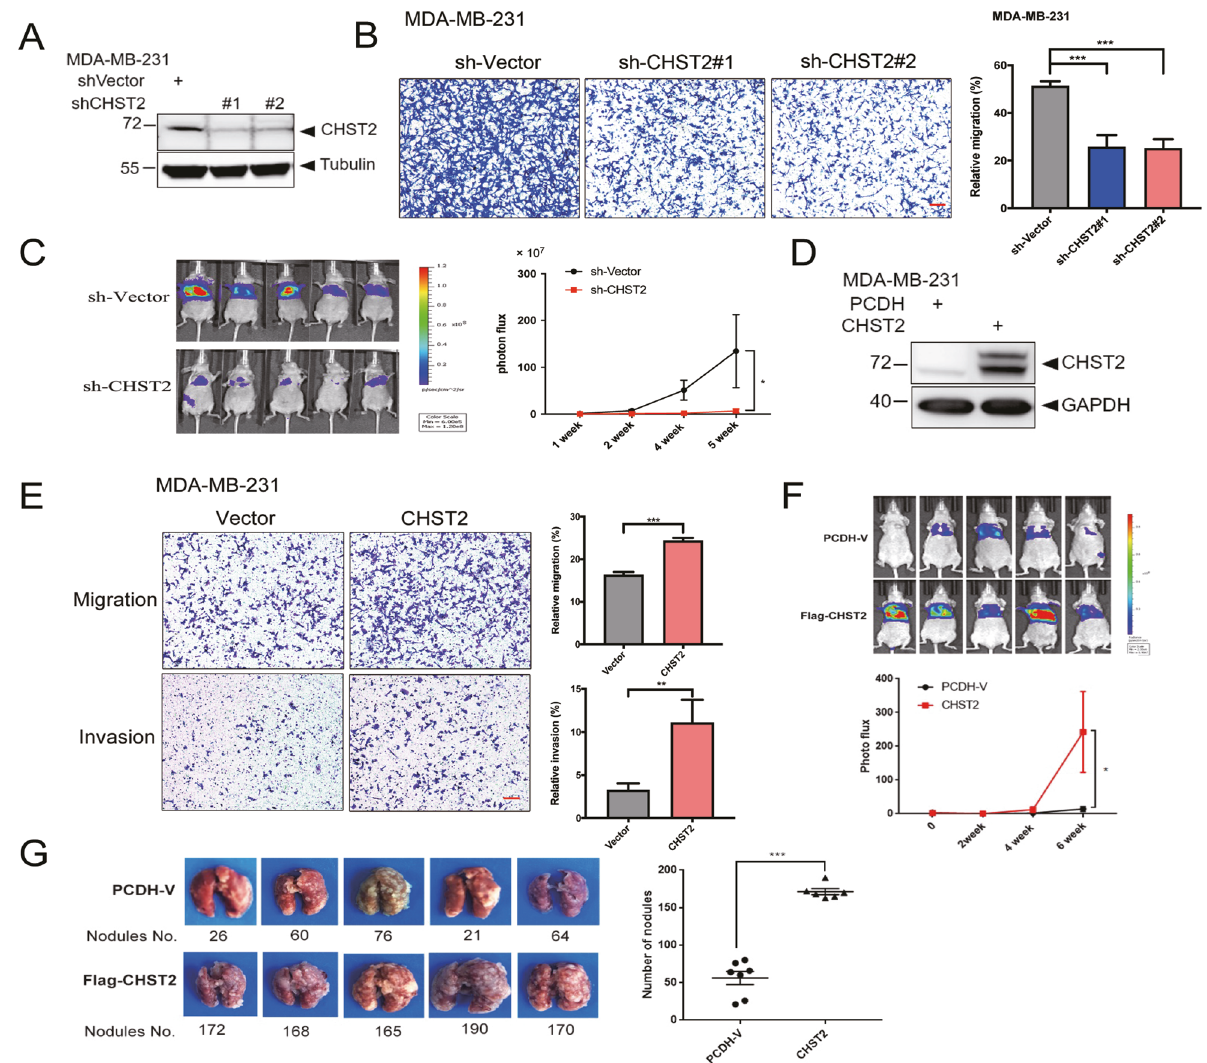
Fig. 2 CHST2 is required for breast cancer cell migration and metastasis. Protein levels of CHST2 were quanti fi ed by western blots in MDA- MB-231 cells with CHST2 knockdown ( A ) or CHST2 overexpression ( D ). Transwell assays show the migration and invasion abilities of MDA-MB- 231-shCHST2 cells ( B ) or MDA-MB-231-CHST2 cells ( E ). Left panel: Representative images of migrated cells, right panel: Statistical analysis of the average migrated cells per fi eld. Data were shown as mean ± SD from three independent experiments. *** P < 0.001, ** P < 0.01, compared with vector groups, 100×, scale bar, 100 μ m. C Tail-vein injection of MDA-MB-231 cells with knockdown of CHST2 for lung metastasis analysis. Left panel: Intensities of lung metastasis in mice at the 5th week were analyzed by bioluminescent imaging (BLI). Right panel: Quanti fi cation of lung photon fl ux at the fi rst, 2nd, 4th, and 5th week. P value was determined using two-way ANOVA, * P < 0.05, compared with vector group ( n = 7 and n = 5, respectively). F Overexpression of CHST2 in MDA-MB-231 cells promoted lung metastasis in vivo. Left panel: Intensities of lung metastasis in mice at the 6th week were analyzed by BLI. Right panel: Quanti fi cation of lung photon fl ux at the 0, 2nd, 4th, and 6th week. P value was measured by two-way ANOVA, * P < 0.05, compared with vector group ( n = 7 and n = 6, respectively). G Overexpression of CHST2 increased the number of metastatic pulmonary surface nodules. Left panel: Shown are representative images of metastatic nodules. Right panel: The average number of metastatic tumor nodules shows a signi fi cant difference between the vector and CHST2 overexpression group ( n = 7 and n = 6, respectively). Data were shown as mean ± SD, *** P < 0.001, compared with vector